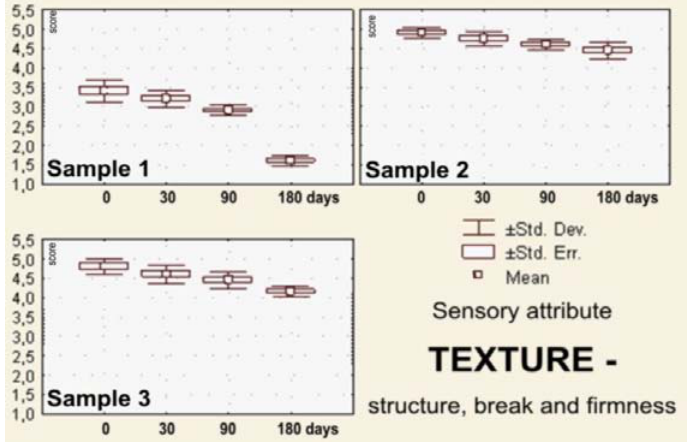
Figure 3. Box-plots for sensory attribute texture —structure, break and firmness of the filled pralines (labels as in the Figure 2), during 180 days of